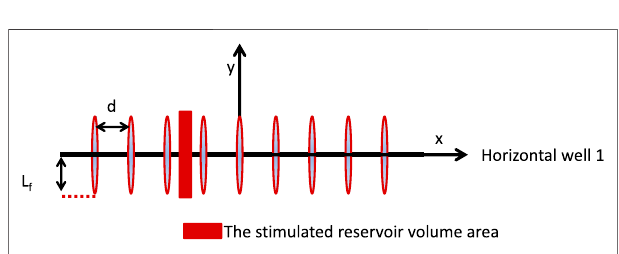
FIGURE 4 | Schematic diagram of interference zone between fractures by synchronous pressure of shale